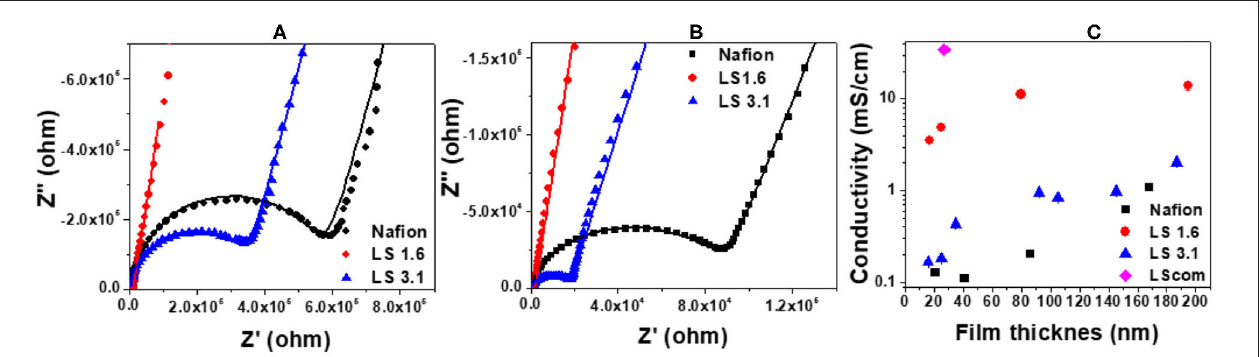
FIGURE 2 | Comparison of electrochemical impedance response of Nafion, LS 1.6, and LS 3.1 films with the thickness (A) straight lines represent the original impedance data and the fits to the data (using an equivalent circuit model), respectively; and (C) conductivity values (with error bars) of Nafion, LS 1.6, LS 3.1, and LScom films are plotted as a function of film thickness. All the films were heat-treated at 100 ◦ C, and the conductivity values (with fit errors) were measured at 90% RH and 22 ◦ ∼ ∼